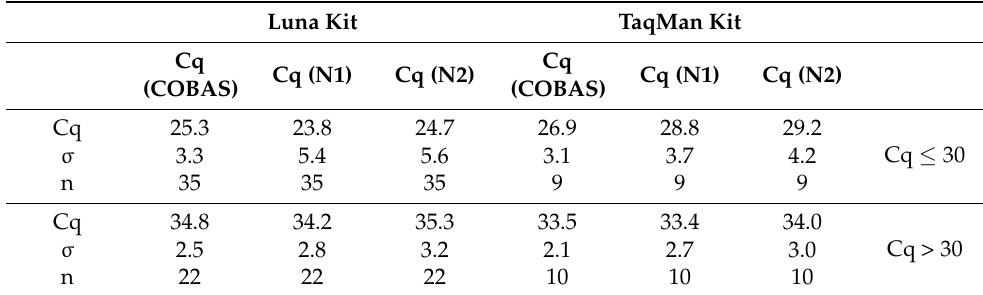
Table 4. Comparison of one-tube RT-qPCR kit